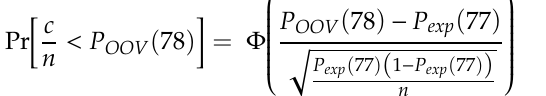
Figure 10. The probability of an incorrect one-bit guess when the weight estimate is correct: After flipping a one-bit, acceptance rate c knowing the weight of the noise vector ( = 78), the OOV algorithm estimates a bit as 1 i ff c 𝑃 (cid:3016)(cid:3016)(cid:3023) (78).